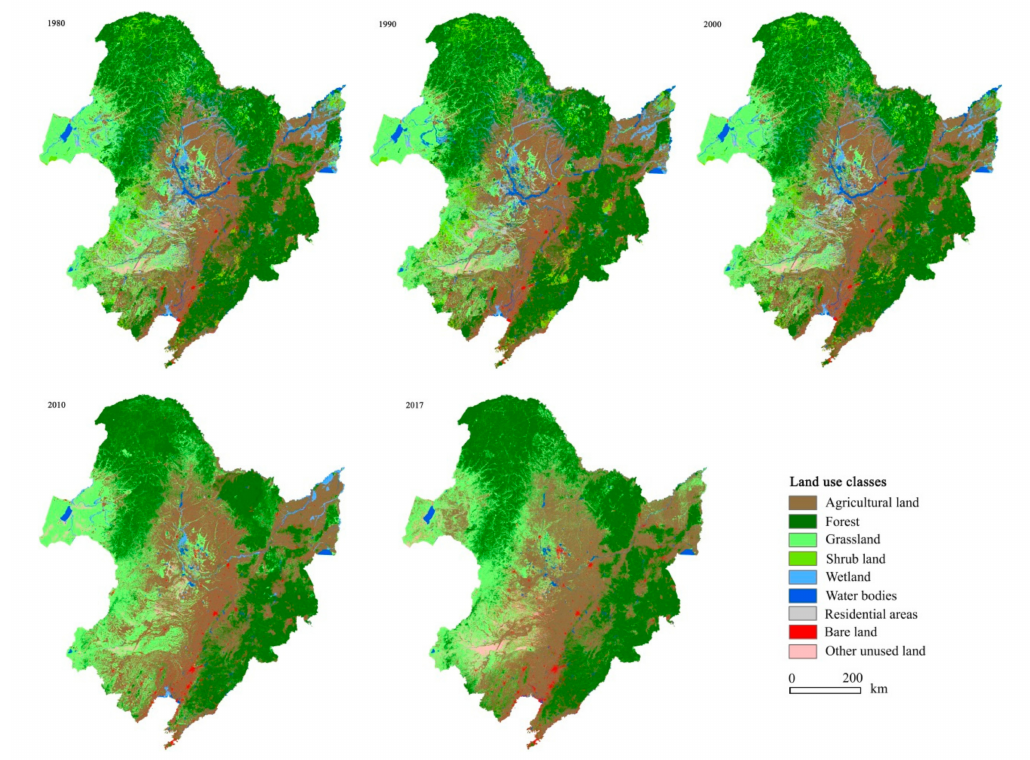
Figure 3. Land use maps in 1980, 1990, 2000, 2010, and 2017 for northeastern China (NEC).